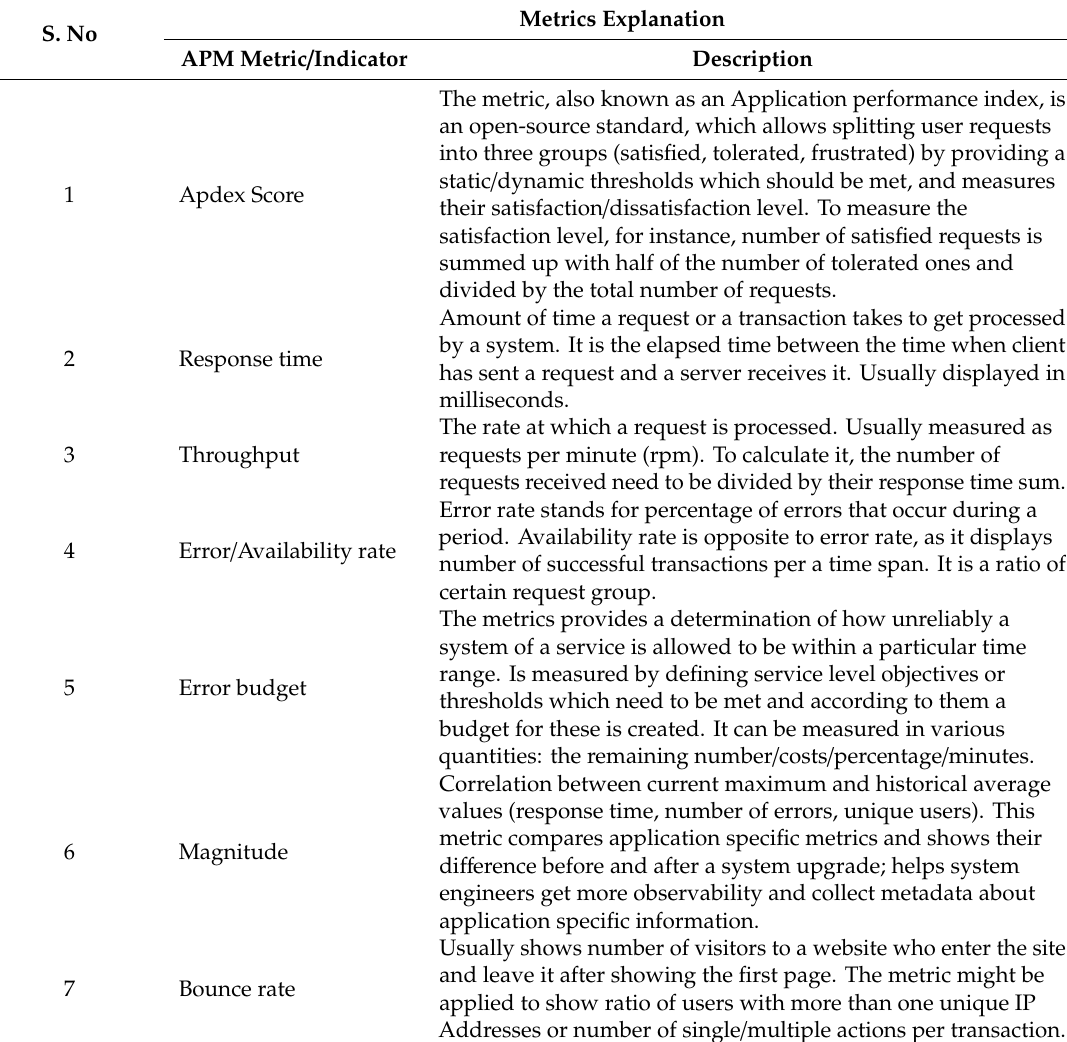
Table 1. Application Performance Monitoring